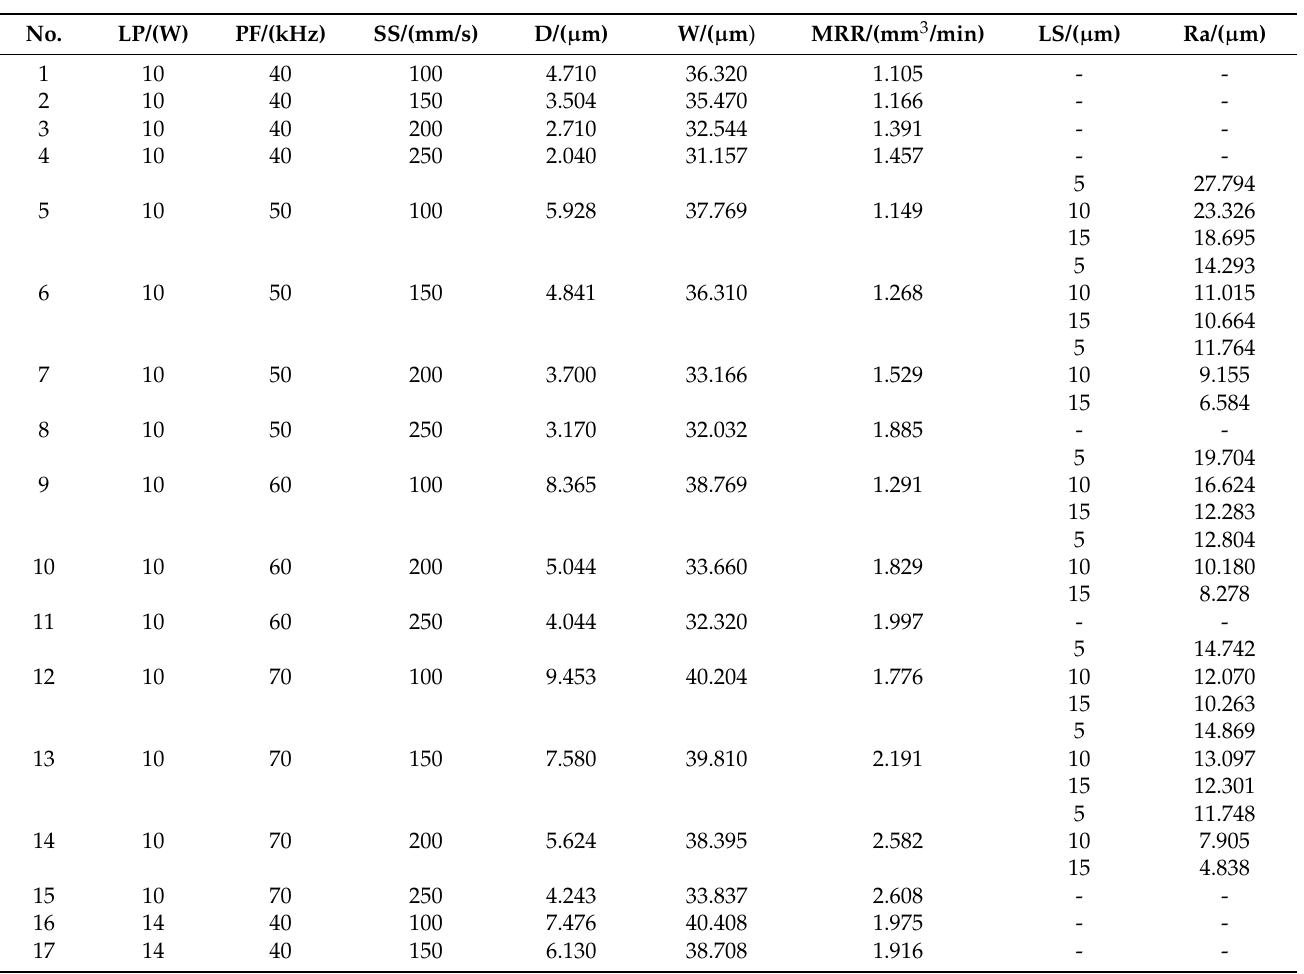
Table A1. Results of the technological